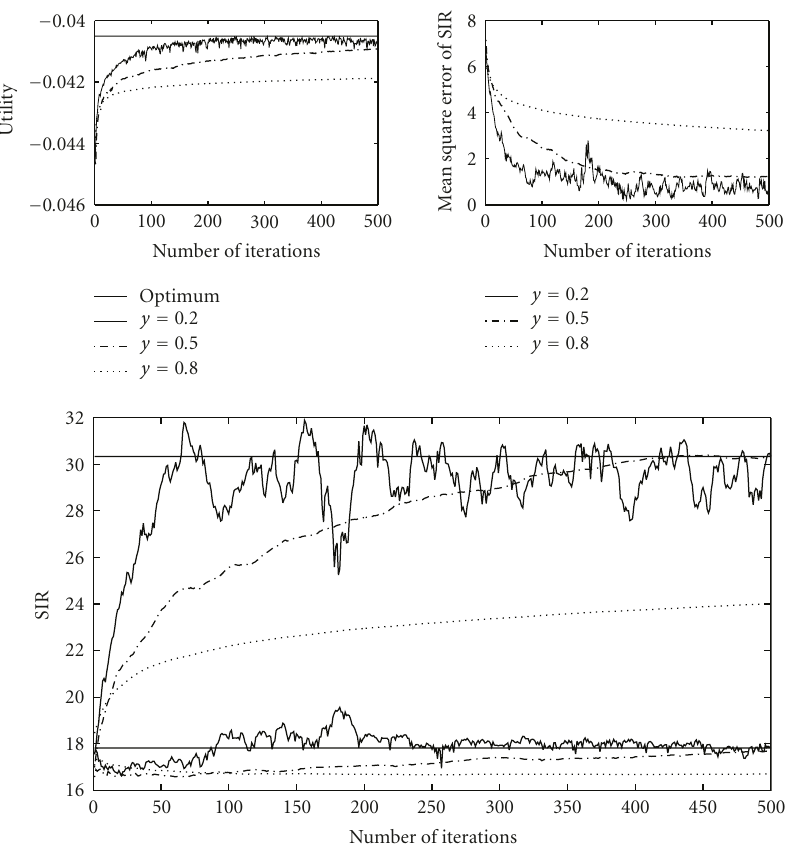
Figure 1: Convergence behavior of the distributed algorithm in case of noisy measurements for di ff erent values of y , c 1 = 30 and c 2 = 0 . 5.